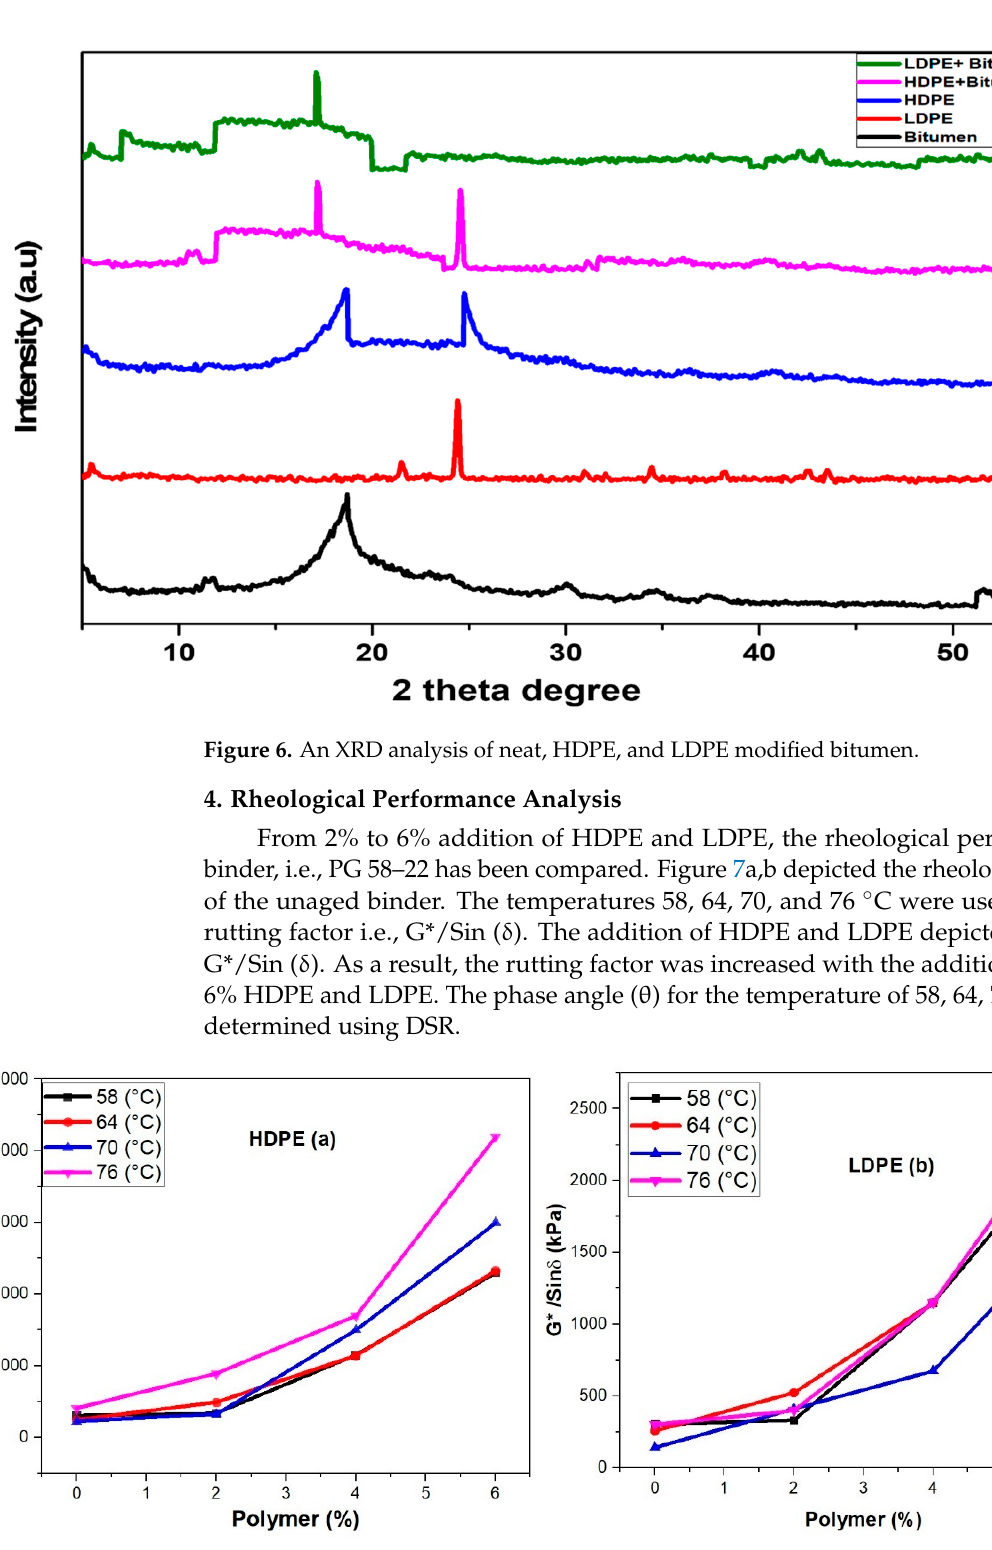
( b ) Figure 8. ( a ) An analysis of G*/Sin ( 𝛿 ) and temperature with HDPE modified bitumen for long-term aging, ( b ) an analysis of G*/Sin ( 𝛿 ) and temperature with LDPE modified bitumen for long-term aging. The phase angle of pure polymer content is less than the neat binder, irrespective of the temperature conditions. Irrespective of the temperature change, the reduction of phase angle is due to the rich phase of the polymer that behaves like an elastic filler in a neat binder matrix [45]. This shows that the polymer’s addition improves the high-temperature performance of asphalt mortar. A decrease in phase angle ( θ ) was observed with the usage of the polymers, as the phase angle is acting as a lag between the applied shear stress and resulting in the shear strain. The lesser the phase angle, the more asphalt mortar can resist permanent deformation, as shown in Tables 4 and 5, respectively.